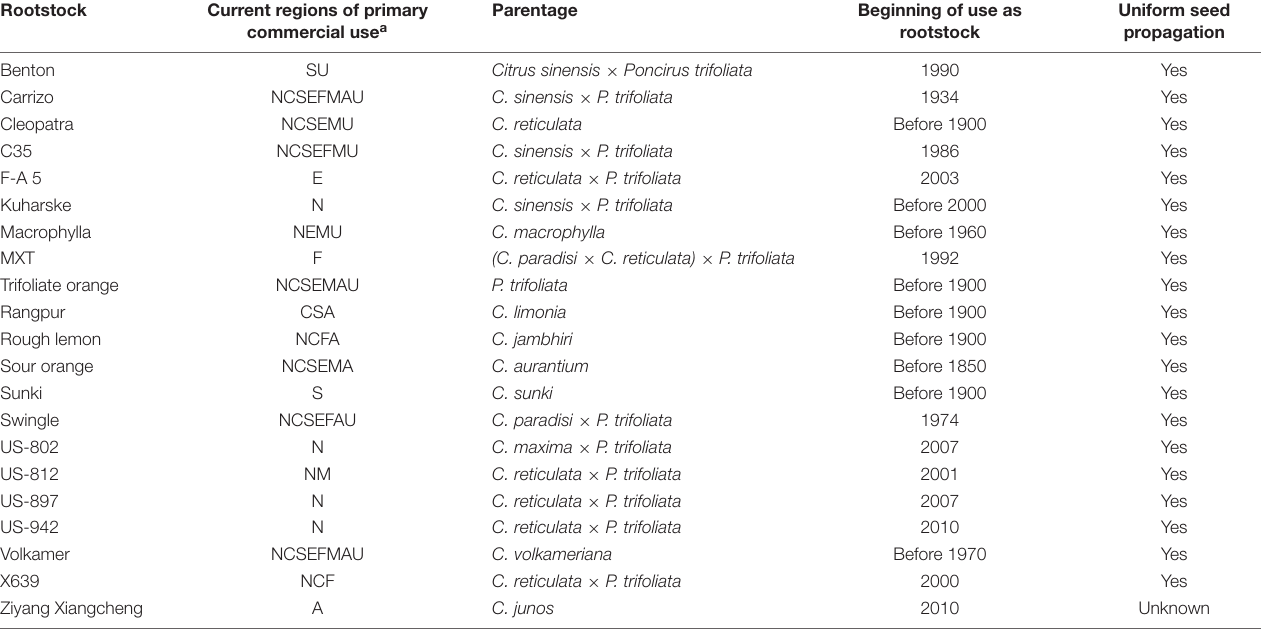
TABLE 1 | Major citrus rootstocks of the world, with regions of primary use, parentage (for those from known crosses), date commercial use began, and uniformity of seed propagation. Rootstock Current regions of primary Parentage Beginning of use as commercial use a